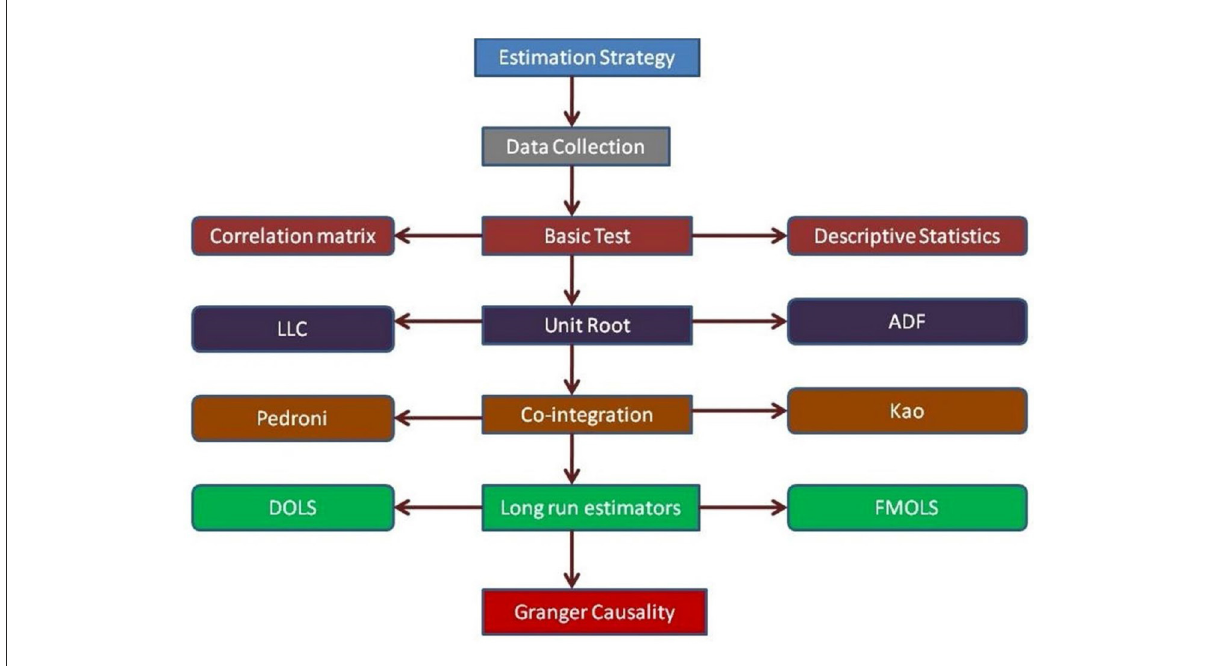
FIGURE2 It shows the process of estimation strategy of this